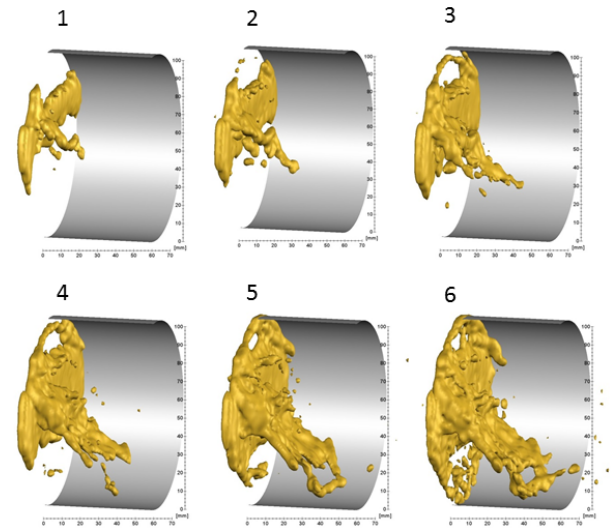
Figure 8. Result of the measurements with ClearPET during ad- vection experiments on the sample in Fig. 7; isosurfaces of the 3% maximum value for six frames (see Table 3). Table 3. Injection parameters of Fig. 8.